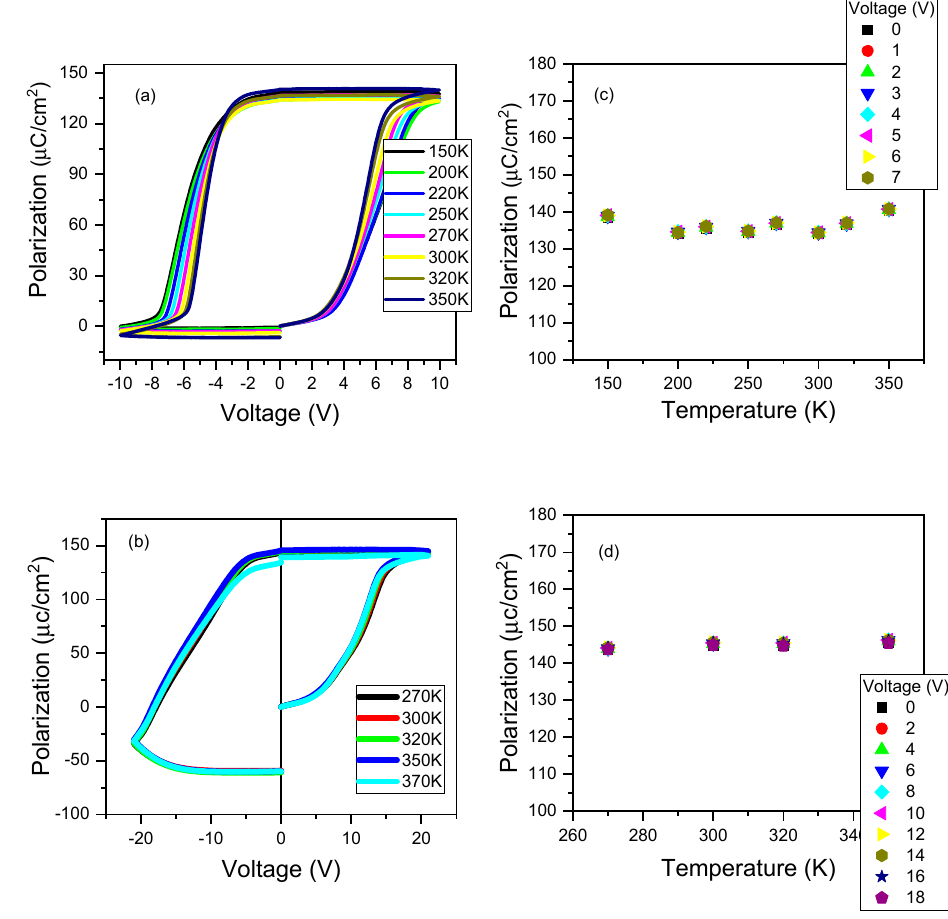
Figure 4. ( a , b ) The hysteresis measurements performed at different temperatures for STON/PZT/SRO and PZT/STON/SRO/STO; ( c , d ) the constant dependence of polarization as a function of temperature for STON/PZT/SRO and PZT/STON/SRO/STO. Further multilayered structures were fabricated with two different insulator thin films deposited on top of the PZT layer: BST/PZT/SRO/STO and Nb 2 O 5 /PZT/SRO/STO. The presence of the insulator layer in contact with the main FE acted as a series capacitor. During switching, the series capacitor was charged and induced an internal field in the FE in the opposite direction to the polarization. This resulted in an induced back-switching effect at 0 V [38]. This phenomenon was revealed for both structures, as shown in Figure 5, for all temperatures. A reduction in the maximum polarization at RT to around 30 and 40 µ C/cm 2 was obtained for Nb 2 O 5 /PZT/SRO/STO and BST/PZT/SRO/STO, respectively. This is explained by the high depolarization fields appearing in these multilayered structures during cooling after deposition at high temperatures. For these structures, the polarization increased with the increasing temperature, and it was found to have a similar behavior as the simple PZT layer, as can be observed in Figures 6a and 7a. The pyroelectric coefficient evaluated indirectly was reduced by a factor of ≈ 2 for both cases, compared with the simple PZT layer. A negative adiabatic temperature change was also obtained.